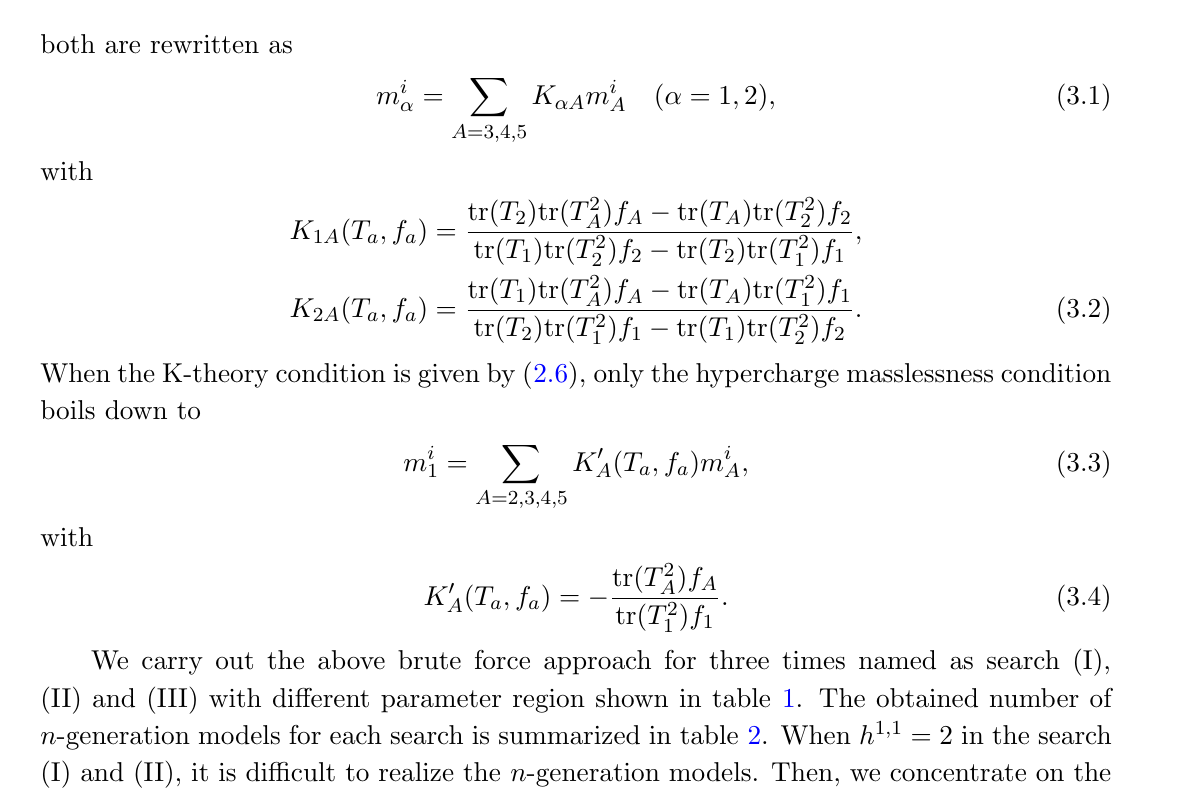
Table 2 . The number of n 6 = 0-generation models and 3-generation models for each search with a speci(cid:12)c h 1 ; 1